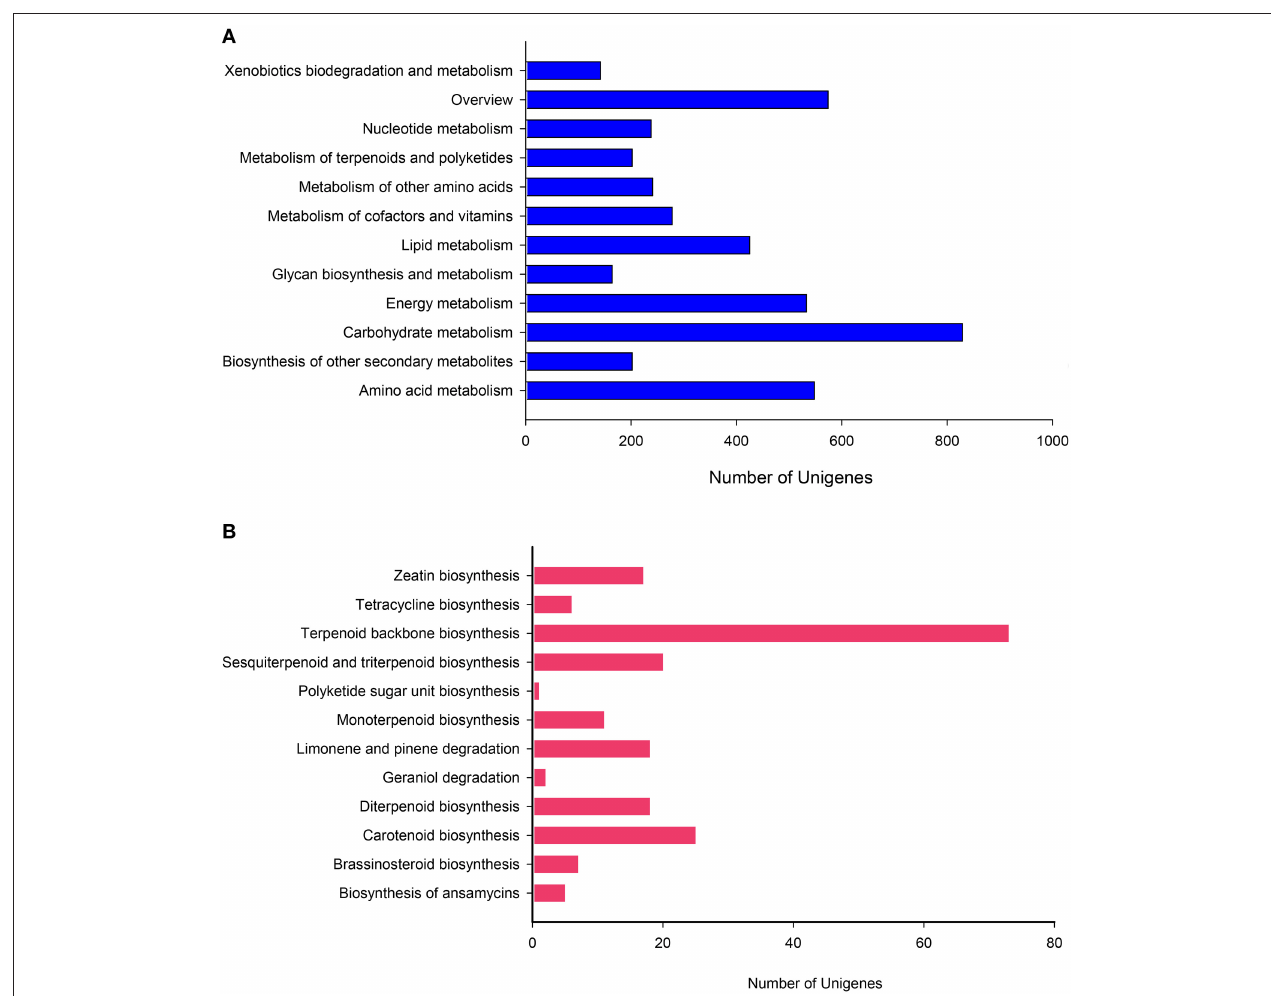
FIGURE 6 | KEGG pathway mapping for D. asperoides . Classification based on (A) metabolism branch and (B) metabolism of terpenoids and polyketides.